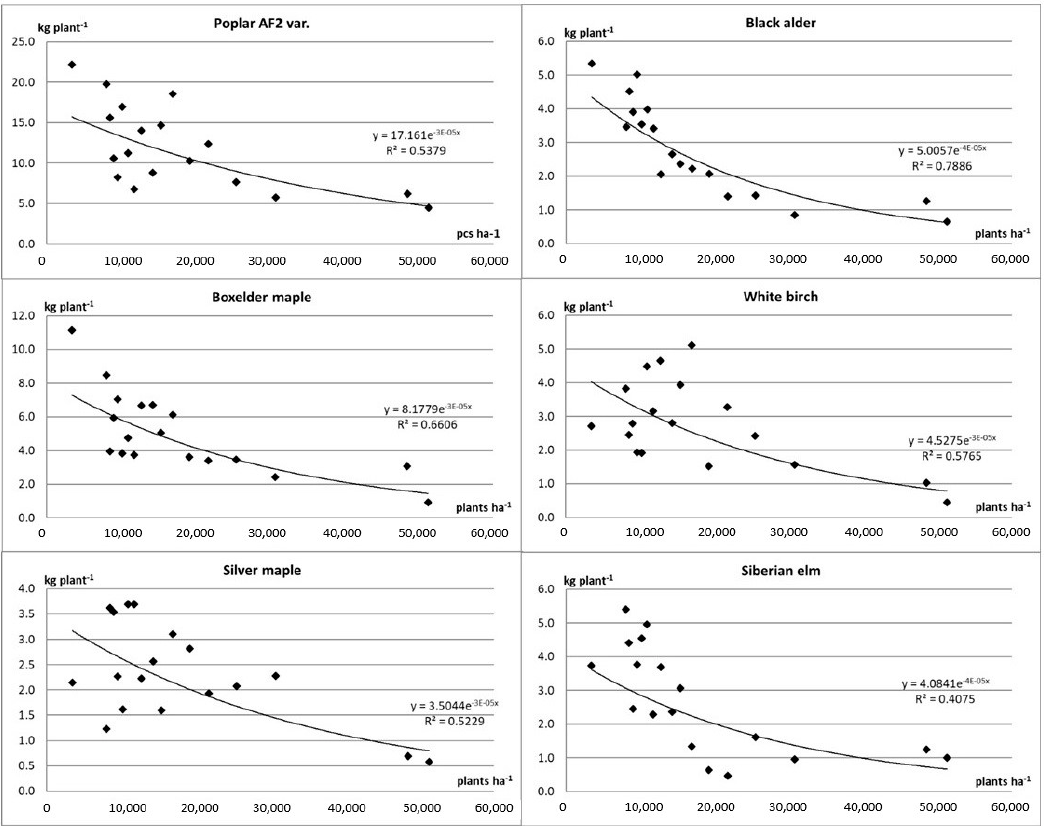
Figure 3. Relationship between dry mass of plant biomass (kg plant − 1 ) and planting density (plants ha − 1 ).